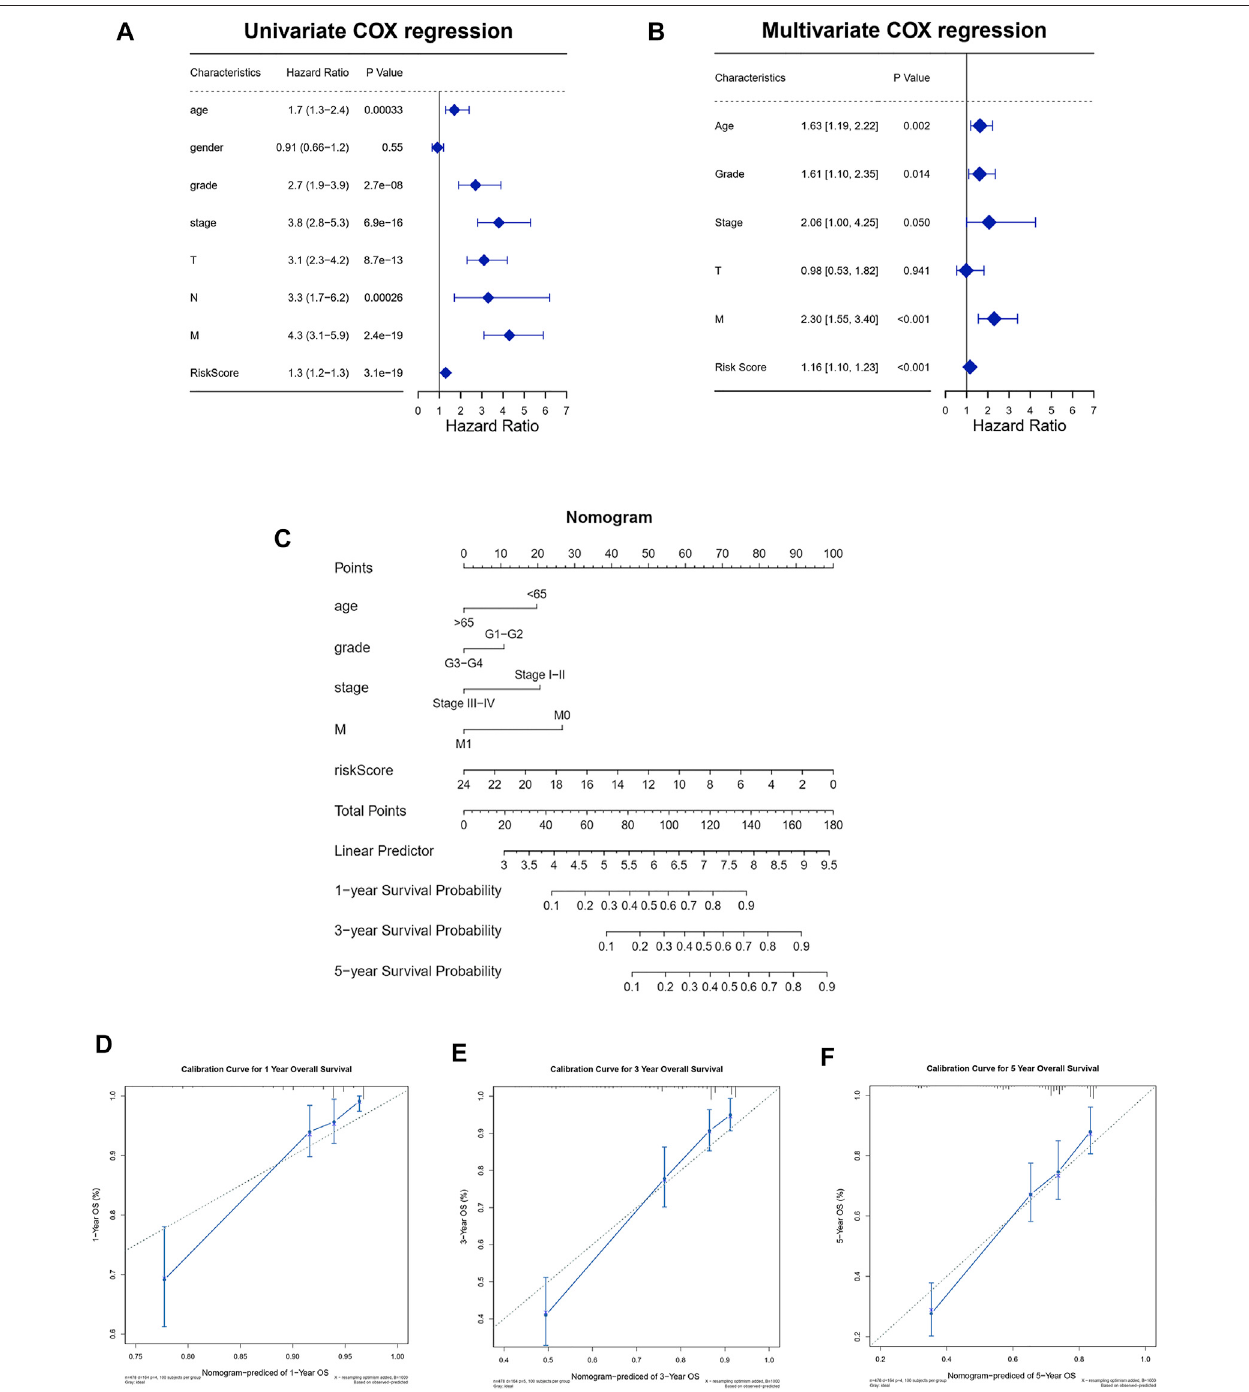
FIGURE 6 | Establishment of the nomogram to predict the survival of patients with ccRCC. (A) Univariate Cox regression analysis among risk score and clinical features for survival. (B) Multivariate Cox regression analysis based on the univariate Cox regression analysis. (C) Establishment of the nomogram predicting survival of patients with ccRCC. (D – F) Calibration curves of the nomogram predicting the 1-year (D) , 3-year (E) , and 5-year (F) survival for patients with ccRCC.